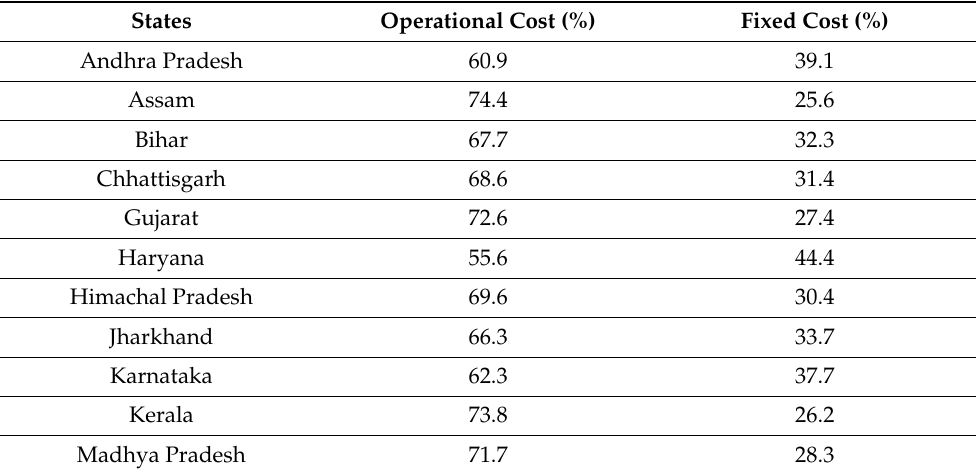
Table 4. Operational cost and fixed cost as a percentage of the total cost of cultivation in different states of India in